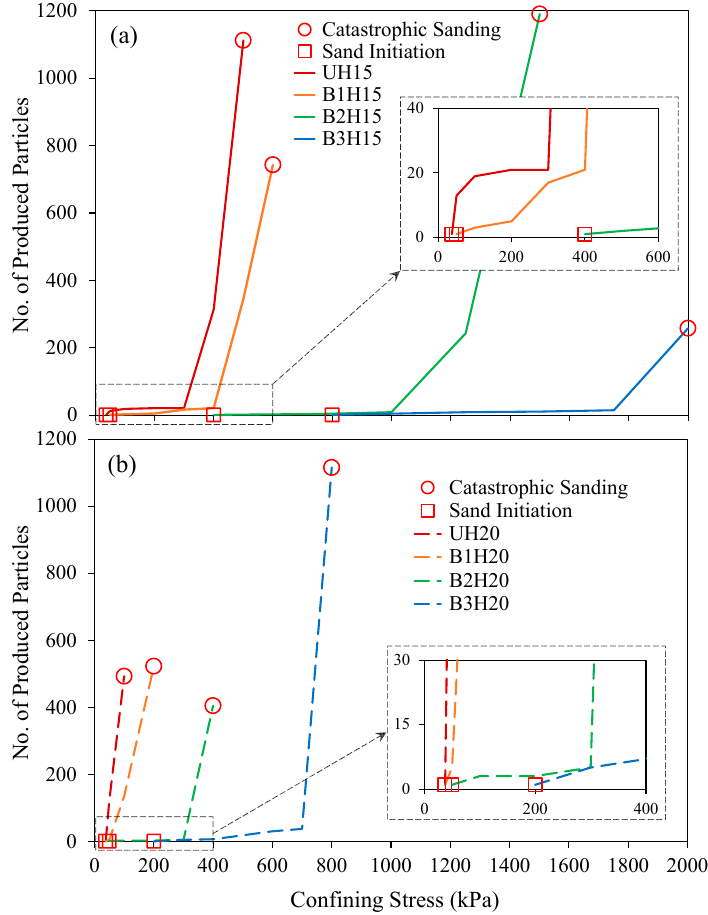
Figure 13. No. of produced particles vs stress level for models with: ( a ) Smaller cavity diameter (inner hole diameter = 15 mm); and ( b ) larger cavity diameter (inner hole diameter = 20 mm).